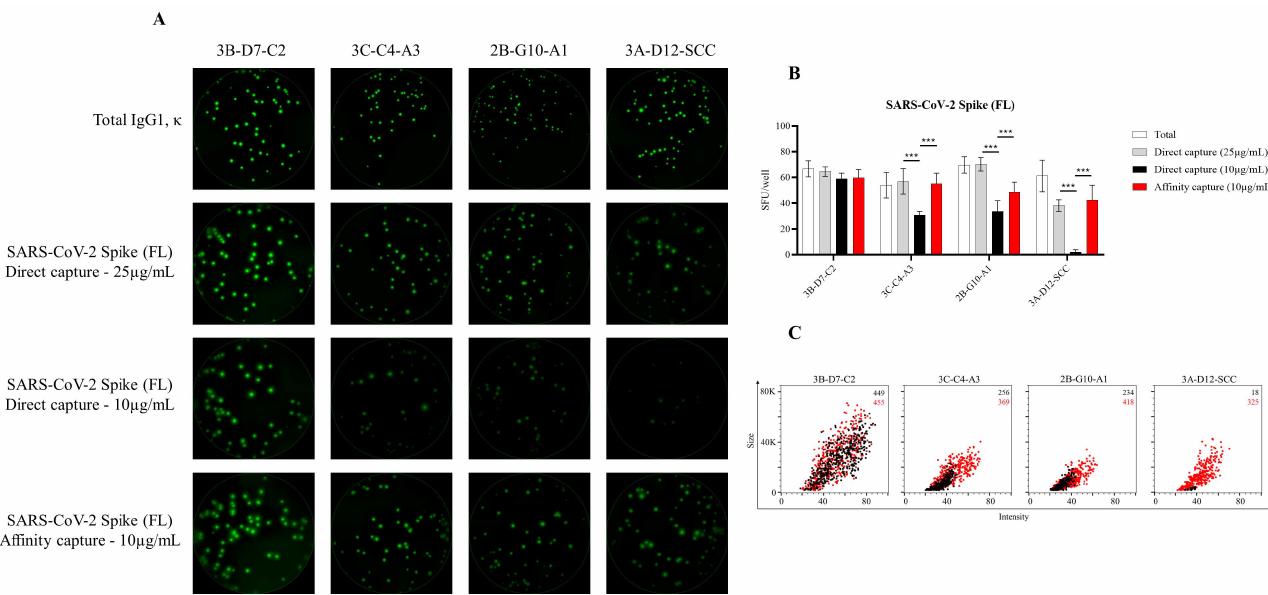
Figure 3. Detection of SARS-CoV-2 Spike-specific FluoroSpots is influenced by protein-coating efficiency. Murine B-cell hybridomas (~100 cells/well) were evaluated for total or antigen-specific FluoroSpot formation (detailed in Materials and Methods). ( A ) Representative well images of murine B-cell hybridomas secreting monoclonal antibody (mAb) (IgG1, κ ) with specificity for the full-length (FL) SARS-CoV-2 Spike protein. Contrast enhancements were uniformly performed on all images to aid their visualization in publication. ( B ) Total or Spike-specific SFU/well (mean ± SD) for each B-cell hybridoma line. Significant differences in SFU/well were determined using an analysis of variation (ANOVA) with Sidak’s post hoc test. *** p < 0.001. ( C ) Spike-specific FluoroSpots were merged into FCS files and visualized as bivariate plots. FluoroSpots originating from assay wells in which Spike protein was directly captured on the membrane (black dots) or through affinity capture (red) are shown as overlays. The combined number of FluoroSpots detected in replicate wells for each of the respective donors is indicated in the inset using the same red/black color